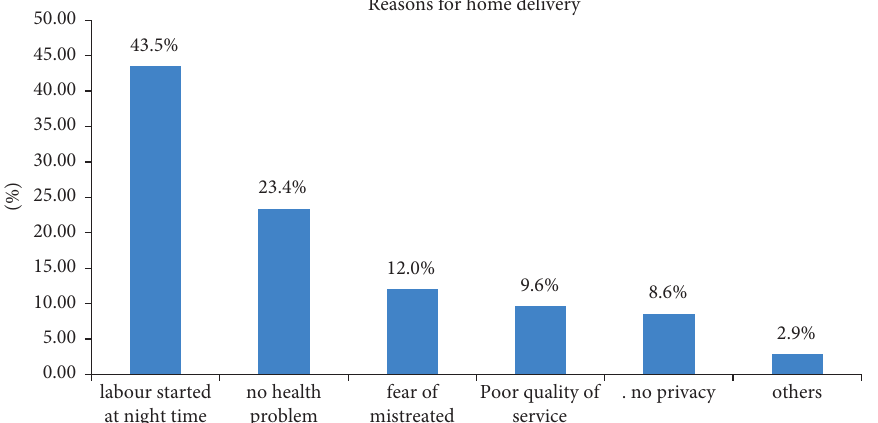
Figure 2: Reason for home delivery among women who gave birth in the last one year at Kersa Woreda, Southwest Ethiopia, July Table 5: Multivariate logistic regression analysis for home delivery at Serbo, Kersa Woreda, Jimma Zone, Southwest Ethiopia, 2021. Variables